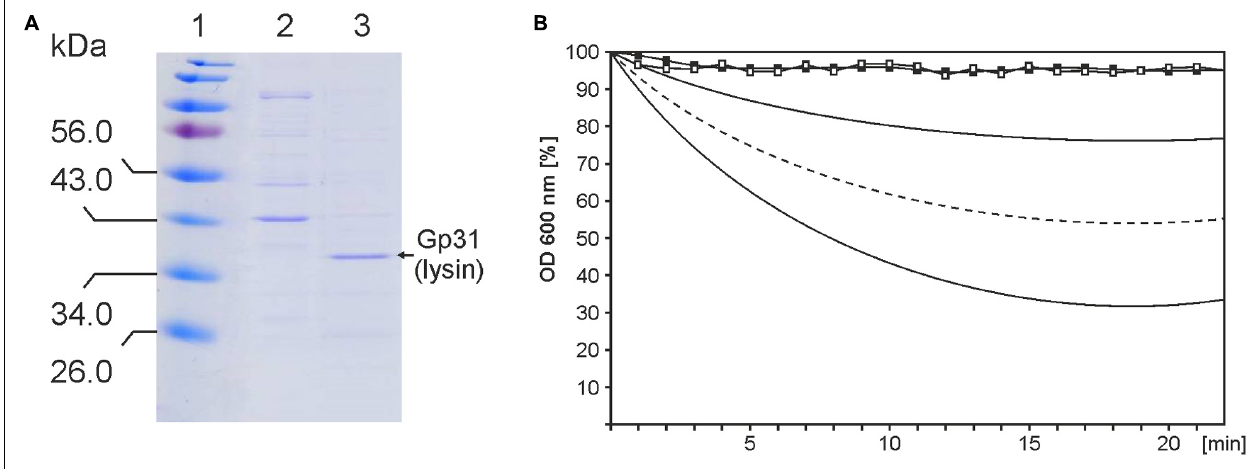
FIGURE 4 | Functional analysis of the (cid:56) E067 lysin. (A) Purification of the lysin by Ni-NTA chromatography. Lane 1, Marker, lane 2, fraction of unbound proteins, and lane 3, lysin eluted from the column. (B) Lytic activity of the lysin. Black and white squares indicate results from cell suspensions of B. thailandensis (negative control) and E. coli strain DH5 α , respectively. The curves below show the range of lysis of spheroplasts of various B. thailandensis and B. vietnamensis strains. Mean values are indicated by the dotted